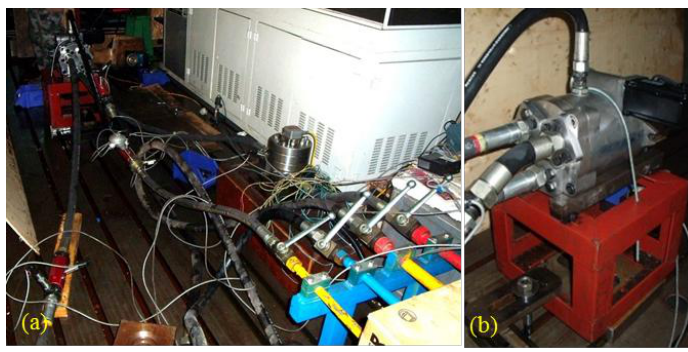
Figure 6. ( a ) The layout of the test bench; and ( b ) photo of the test prototype.